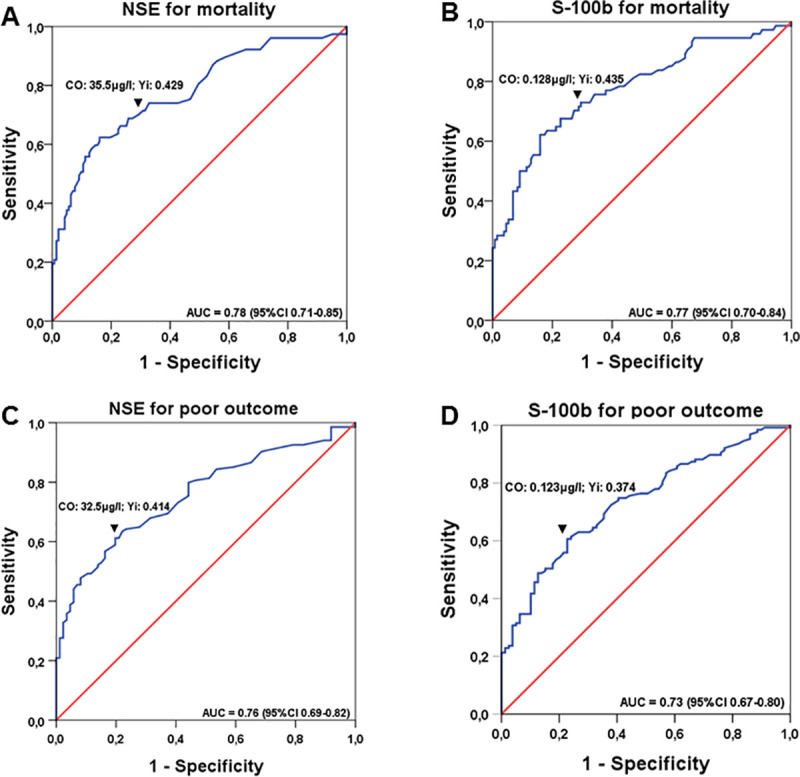
ROC curves for determining cut-off values of NSE and S-100b for mortality and neurological outcome: ROC analysis for NSE (A and C) and S-100b (B and D) are presented for mortality (A and B), and neurological outcome (C and D), respectively, with corresponding areas under the curve (AUC) and confidence-intervals (CI). Cut-off values (co) identified by highest Youden-index (Yi) are shown above downwards pointing arrowheads (▼).